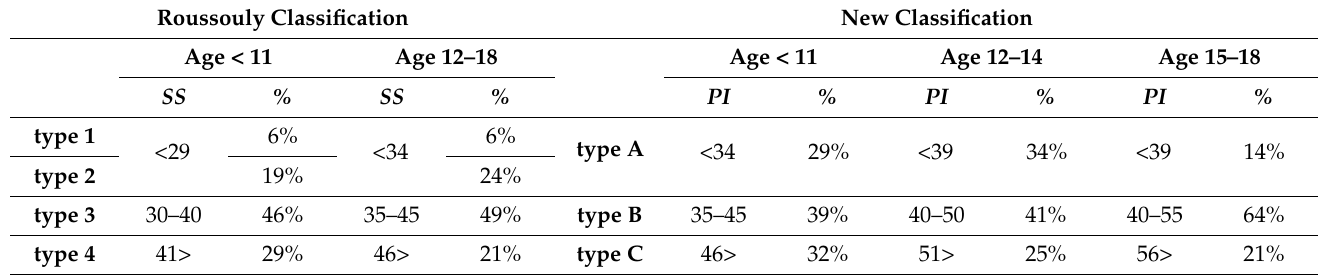
Table 4. Newly defined limits in the Roussouly classification of sacral slope (SS) to distinguish the different types in different age groups during growth. Limits of pelvic incidence (PI) for the new classification in different age groups during growth. Distribution of the Roussouly classification and the new classification types in the different groups.